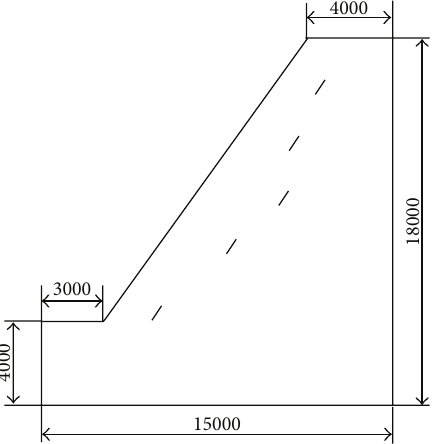
Figure 1: Dimensions of the mining rock